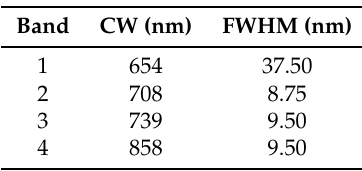
Table 1. Configuration of the multispectral sensor. Central wavelengths (CW) and the full-width at half-maximum (FWHM) bandwidth are given for each band.